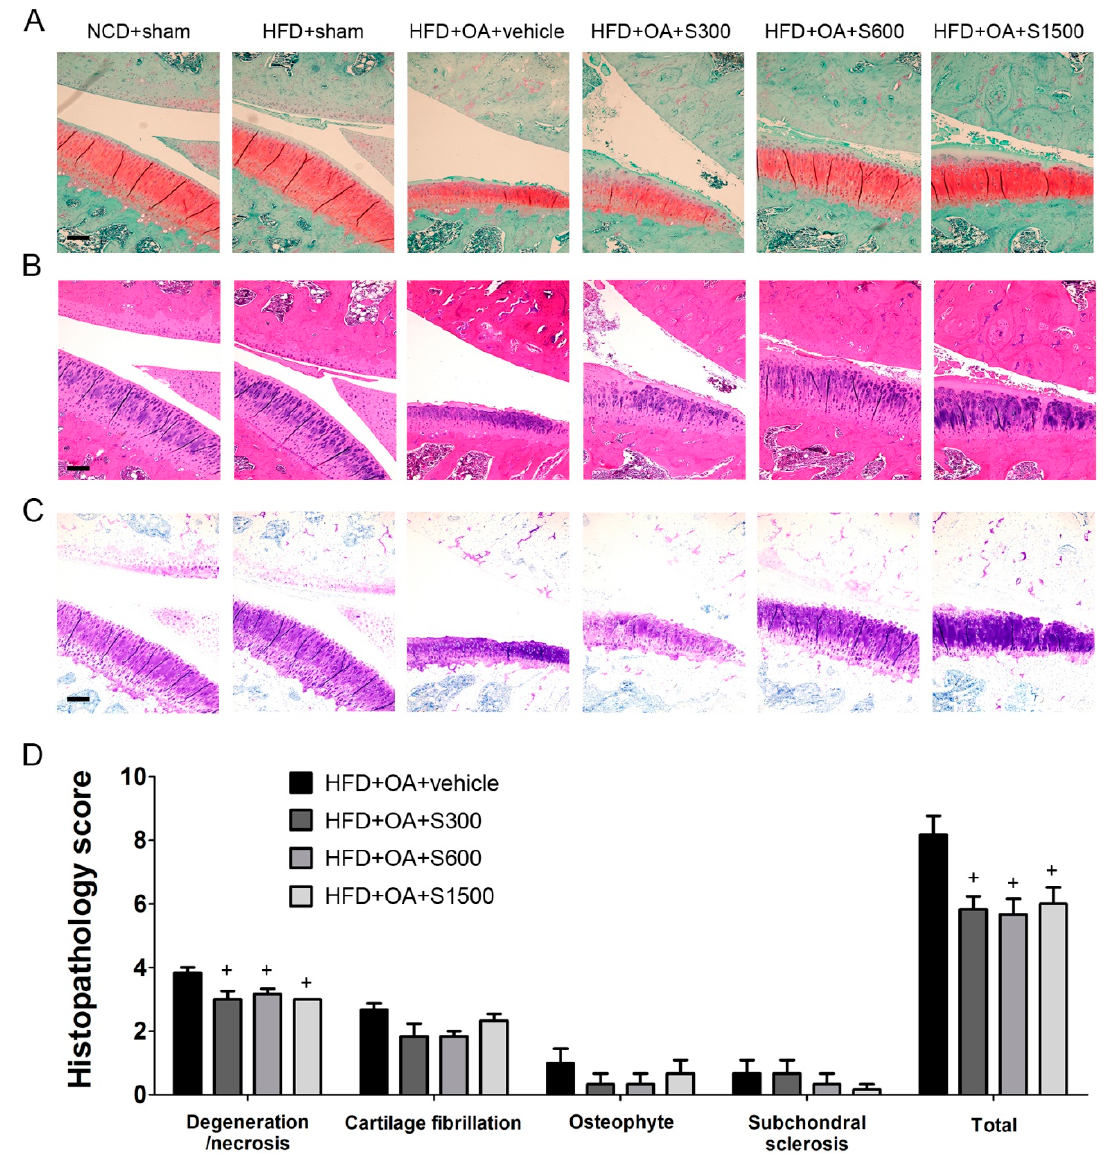
Figure 6. Histology examination of joints after treatment with Shiikuwasha Extract (SE). Rats underwent ACLT / MMx in the right knee. SE was administered orally daily for 9 weeks after the operation. The knee joints of rats with OA were stained with ( A ) Fast Green / Safranin-O, ( B ) H&E and ( C ) toluidine blue. ( × 100 magnification). Scale bars = 200 µ m. ( D ) Joint sections were scored for the degree of degeneration / necrosis, cartilage fibrillation, osteophyte and subchondral sclerosis. The data are expressed as means ± SEM ( n = 6). + p < 0.05 when compared to the vehicle group. The letters were calculated by one-way ANOVA and Duncan’s multiple range test.